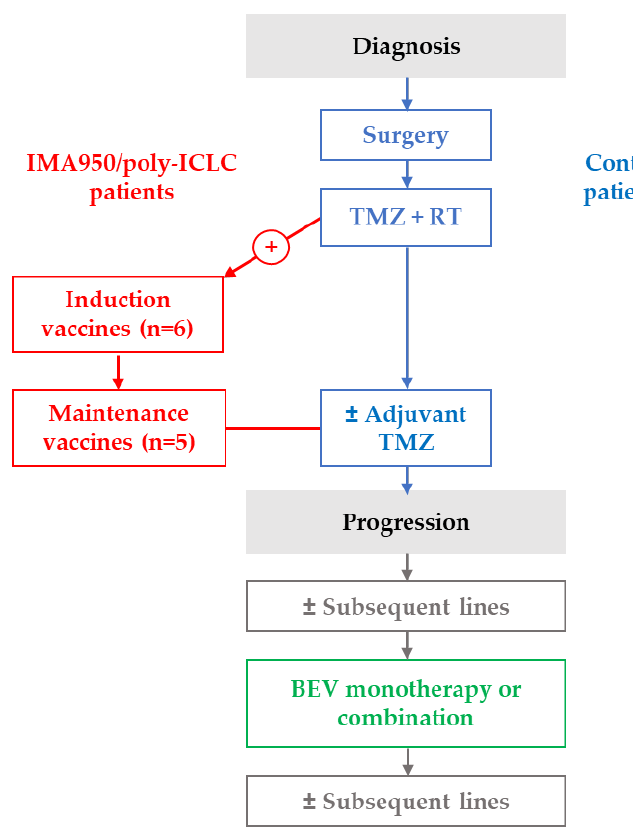
Figure 3. Overview of treatment timelines. RT, radiotherapy; TMZ, temozolomide.